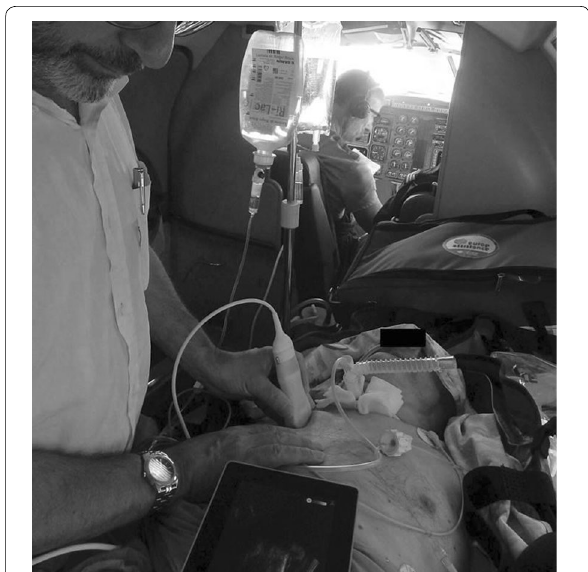
Fig. 3 One single machine, well operated, can replace more than just radiography, even CT in strategic areas (lungs mainly). The small size, the light weight are mandatory criteria for life-saving use in this airplane, but the same spirit can be found at ground level, in ICUs or many other